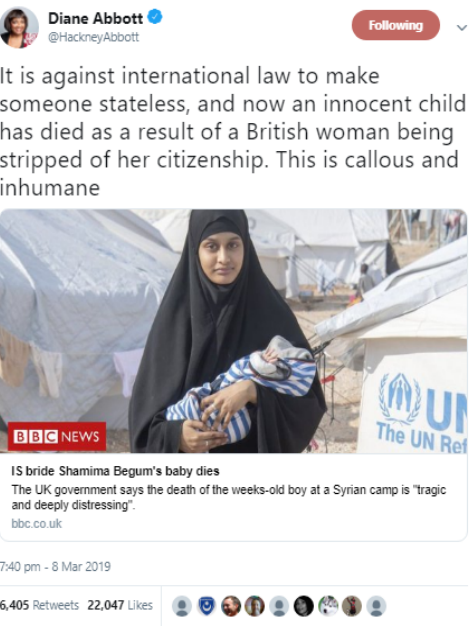
Figure 3. Tweet from Shadow Home Secretary Diane Abbott, 8 March 2019.